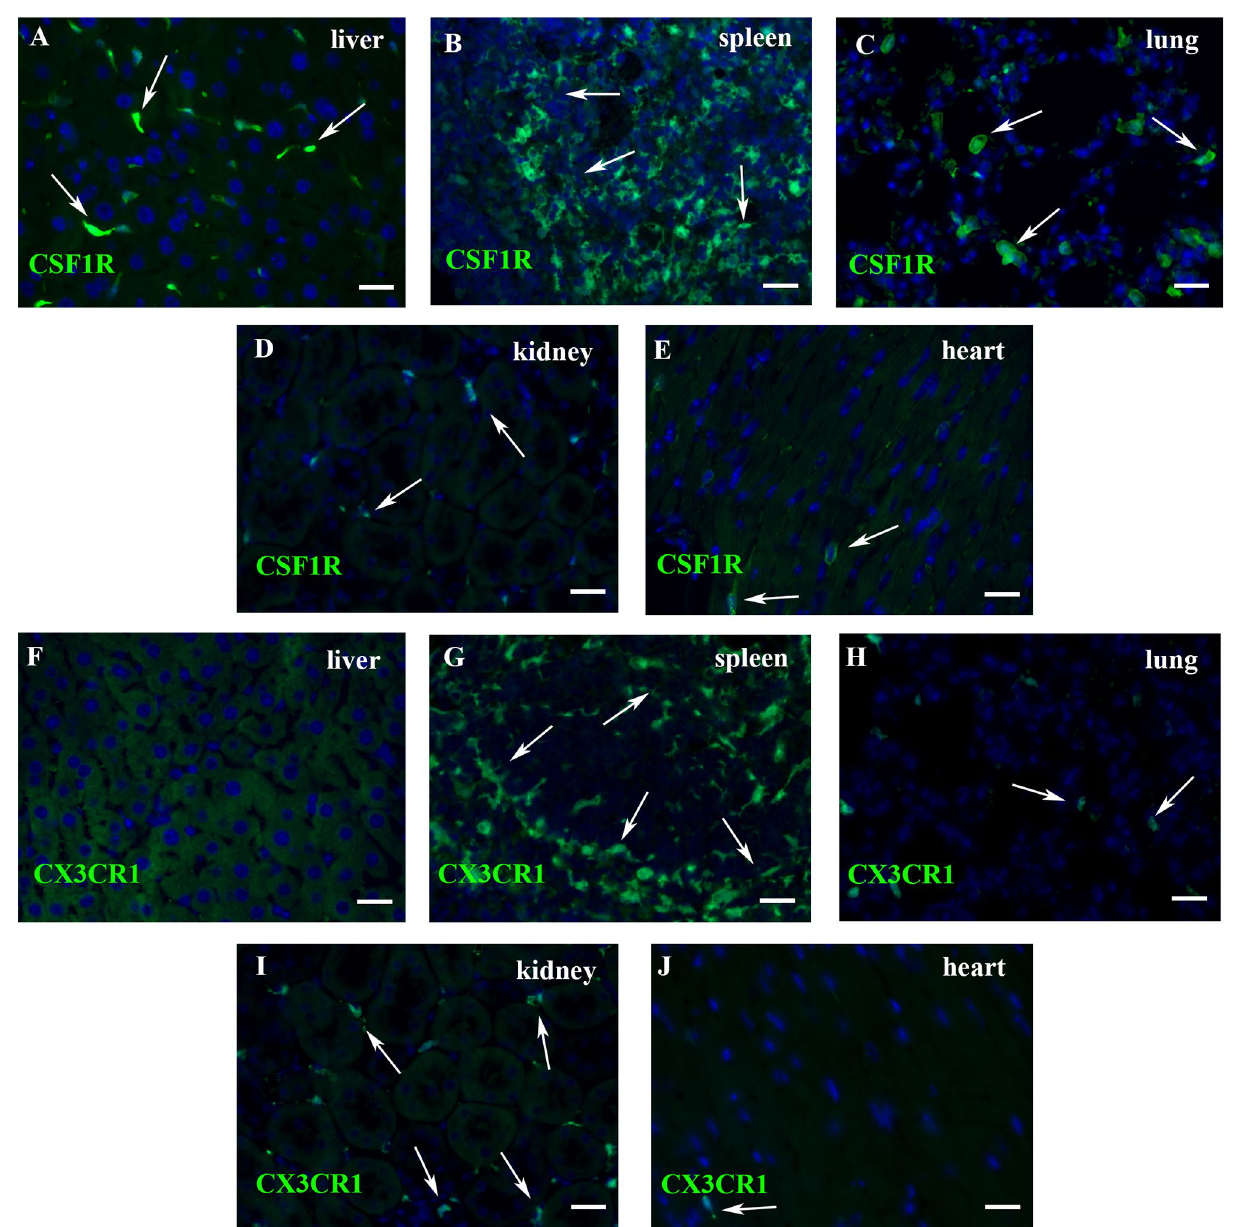
Figure 1. Use of the CSF1R-EGFP and CX3CR1 GFP reporter mice to identify mouse macrophages in normal tissues. A-E: Representative images show identification of CSF1R+ cells (arrows) in the liver ( A ), splenic red pulp ( B ), pulmonary parenchyma ( C ), kidney ( D ) and heart ( E ) of young adult CSF1R-EGFP mice. ( F – J ) Immunofluorescent staining of sections from CX3CR1 GFP reporter mice. Hepatic macrophages are not labeled for CX3CR1 ( F ). CX3CR1+ cells are identified in the white pulp of the spleen ( G ) and in the lung ( H ). Sparse populations of CX3CR1+ cells are found in the kidney ( I ) and in the heart ( J ). Scale bar: 20